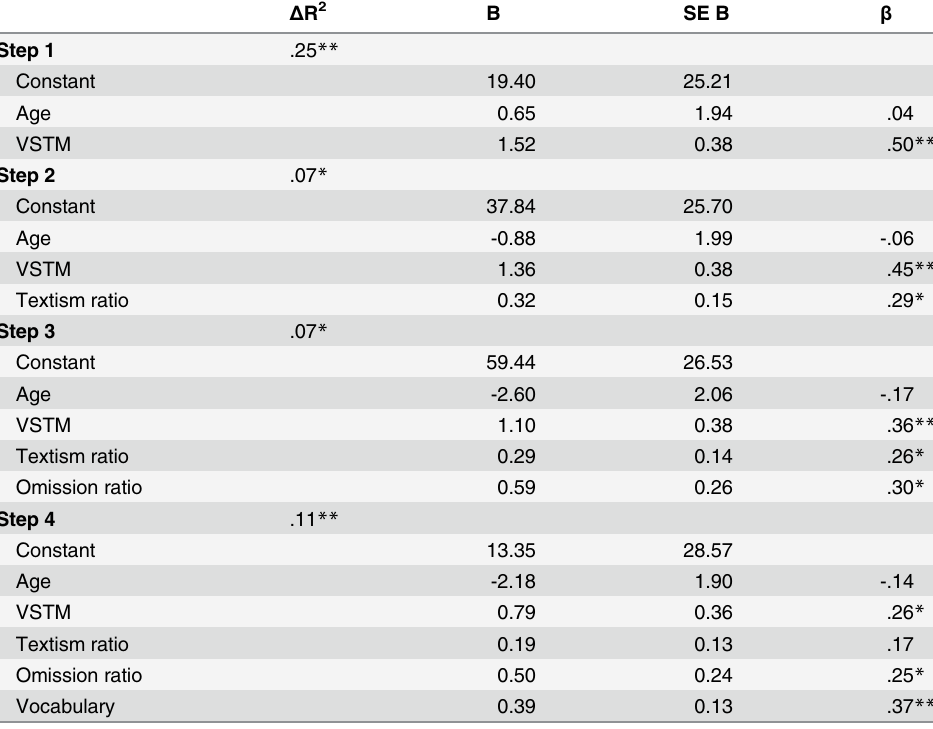
Table 9. Hierarchical regression analysis with children ’ s grammar scores as dependent variable.